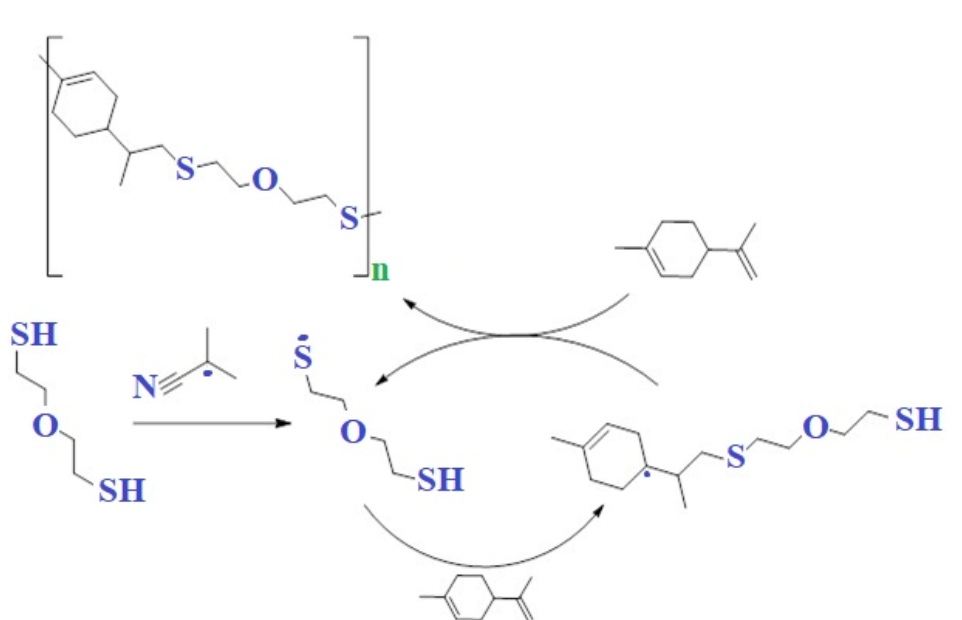
Figure 9. Scheme of the reaction of copolymerization of limonene with 2-mercaptoethyl ether using AIBN as an initiator.